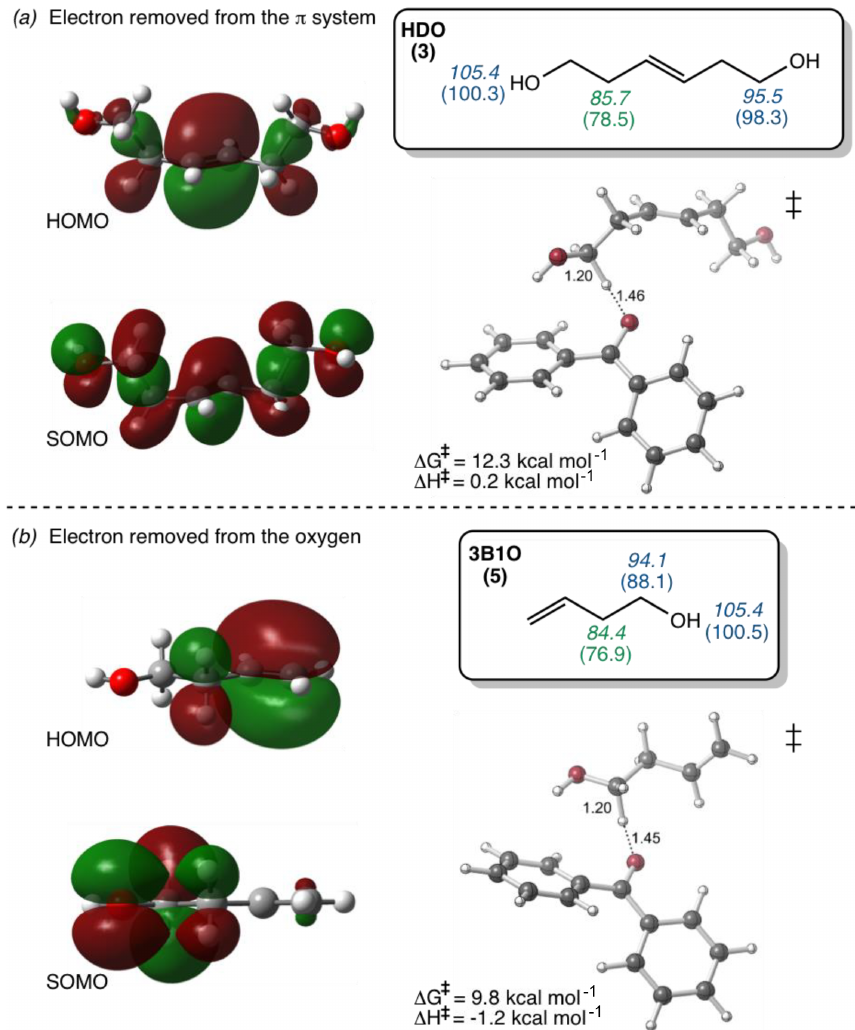
Figure 4. Diagrams of the highest occupied molecular orbitals (HOMOs) of the alkenes before oxidation, the singly occupied molecular orbitals (SOMOs) after the removal of one electron from the alkenes, and the lowest-energy transition-state structures (‡) of alkenes 3 and 5. Bond dissociation enthalpy (italicized) and free energy (in parentheses) for various hydrogen atoms (in kcalmol − 1 ) for each alkene are shown in the boxes. Numbers in green are the lowest values and thus represent the most labile hydrogen in each alkene. (a) The electron removed during H abstraction of HDO is predicted to come from the π system, but this results in delocalization due to hyperconjugation. (b) The electron removed from 3B1O during H abstraction is predicted to come from the oxygen. See Tables S2 and S3 for HOMO–SOMO structures and Fig. S4 for the bond dissociation enthalpies and free energies for other